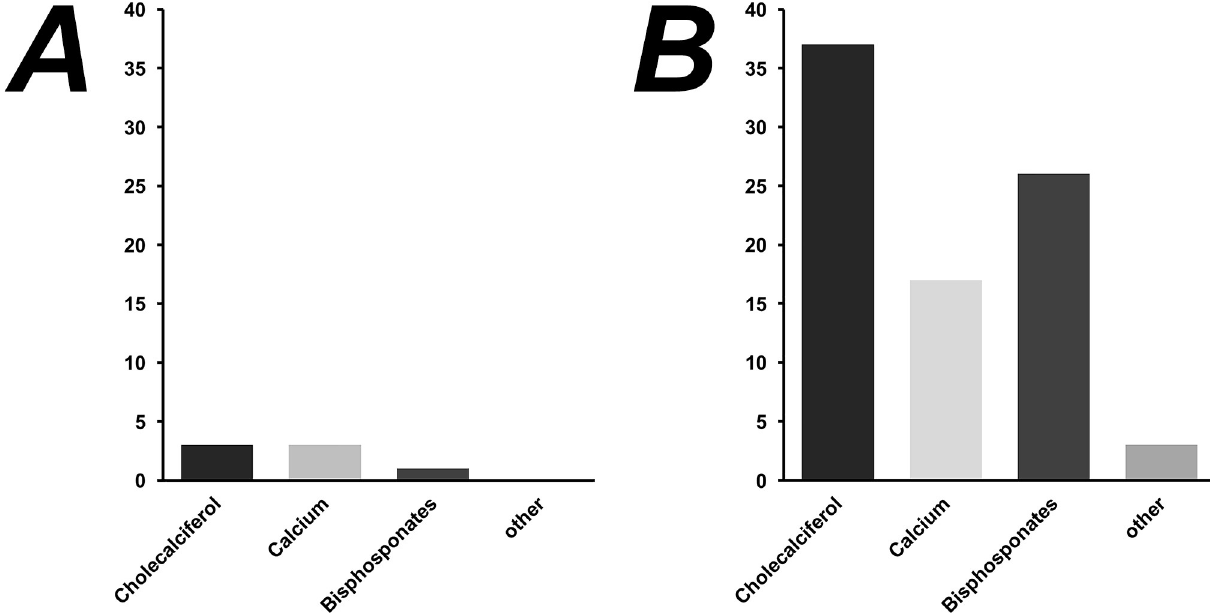
Fig 2. Overall prescribed anti-osteoporotic medication in (A) male (B) female patients.